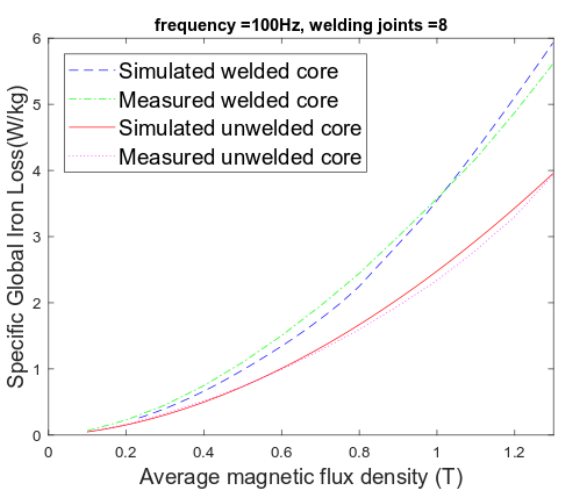
Figure 10. Comparison of the simulated specific losses and measured specific losses as a function of peak flux density for 100 Hz and 8 welding seams. The simulation curve is obtained by fitting the measured data at different frequencies of a stack with 4 weld seams.